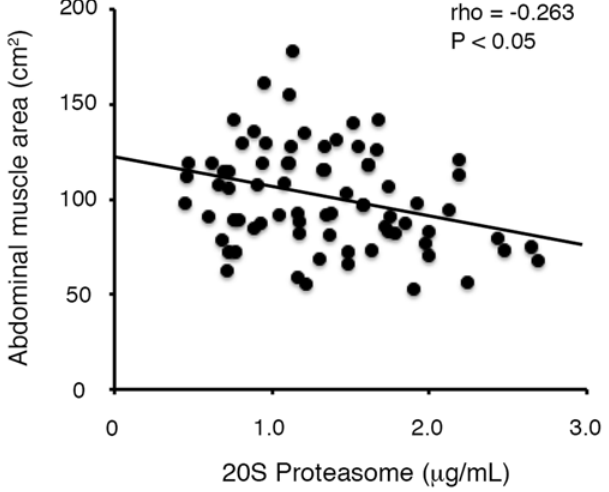
Fig 2. Association between abdominal muscle areas and 20S proteasome